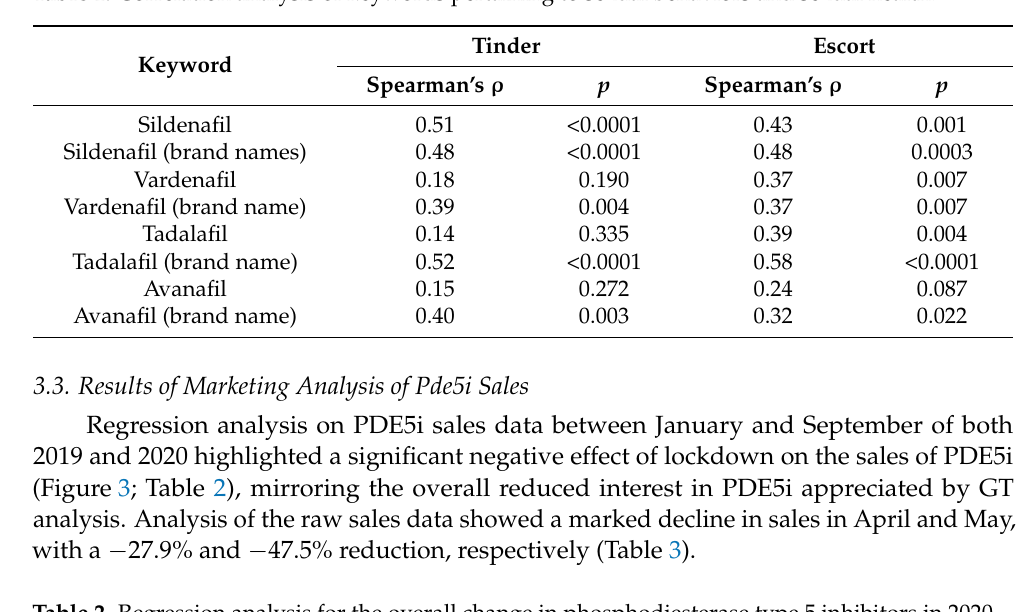
Table 2. Regression analysis for the overall change in phosphodiesterase type 5 inhibitors in 2020.